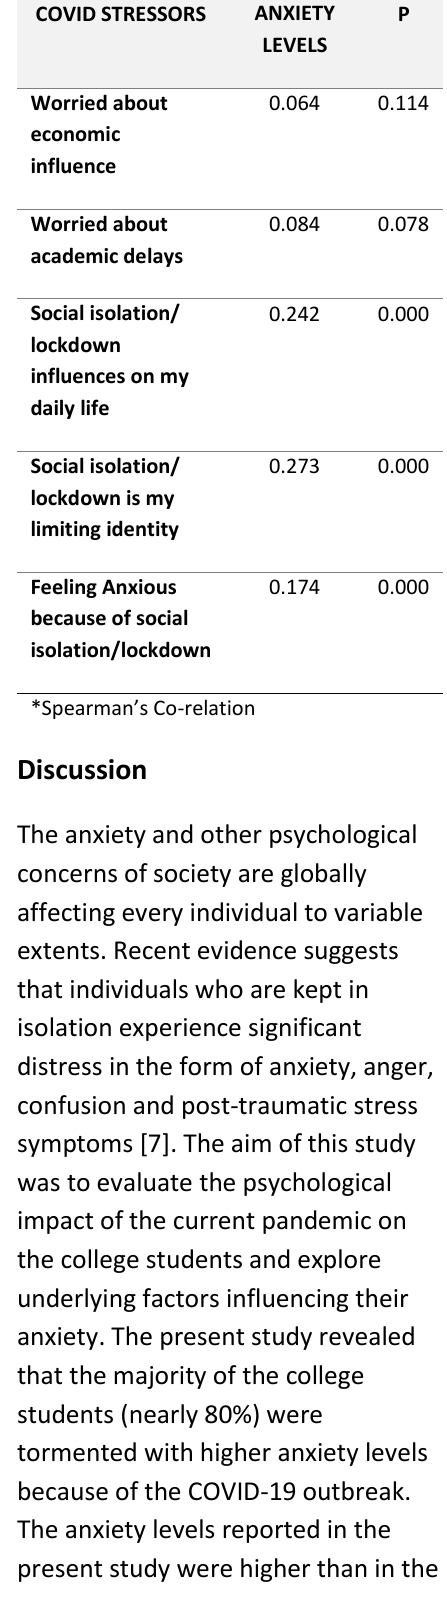
Table 4: Correlation analysis between COVID related stressors and students